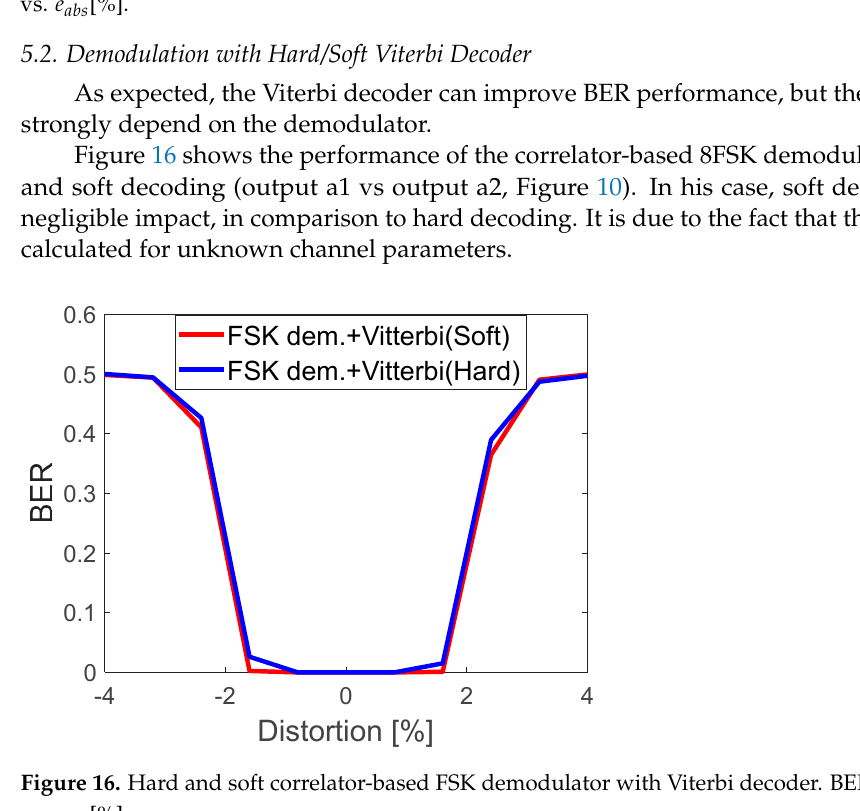
Figure 17. Hard and soft NN-based FSK demodulator with Viterbi decoder. BER performance vs. 𝑒 (cid:3028)(cid:3029)(cid:3046) [%] 6. Conclusions In this article, the 8FSK modulation was proposed for covert communication based on the superposition of the signal. This modulation provides the possibility of transmitter and receiver low complexity and assists considerably in the effective practical implemen- tation of such a system. The main advantage of this solution is the non-coherent transmis- sion and a lower probability of detection by the intruder, thanks to non-constant constel- lation points on the constellation diagram. This is a major difference from a typical solu- tion, based on the constant point of the phase modulation. Inherently, the covert signal suffers from non-deal SIC operation caused by hardware impairments and estimation channel gain error, mainly because of the low energy of the hidden signal. As was shown, even small errors severely affect the correlator-based detector performance. To solve this problem, an NN-based detector was proposed. Such a detector highly outperforms tradi- tional FSK correlator-based demodulator. The additional use of channel coding improves the performance of the system. In this case, the metrics calculated based on NN